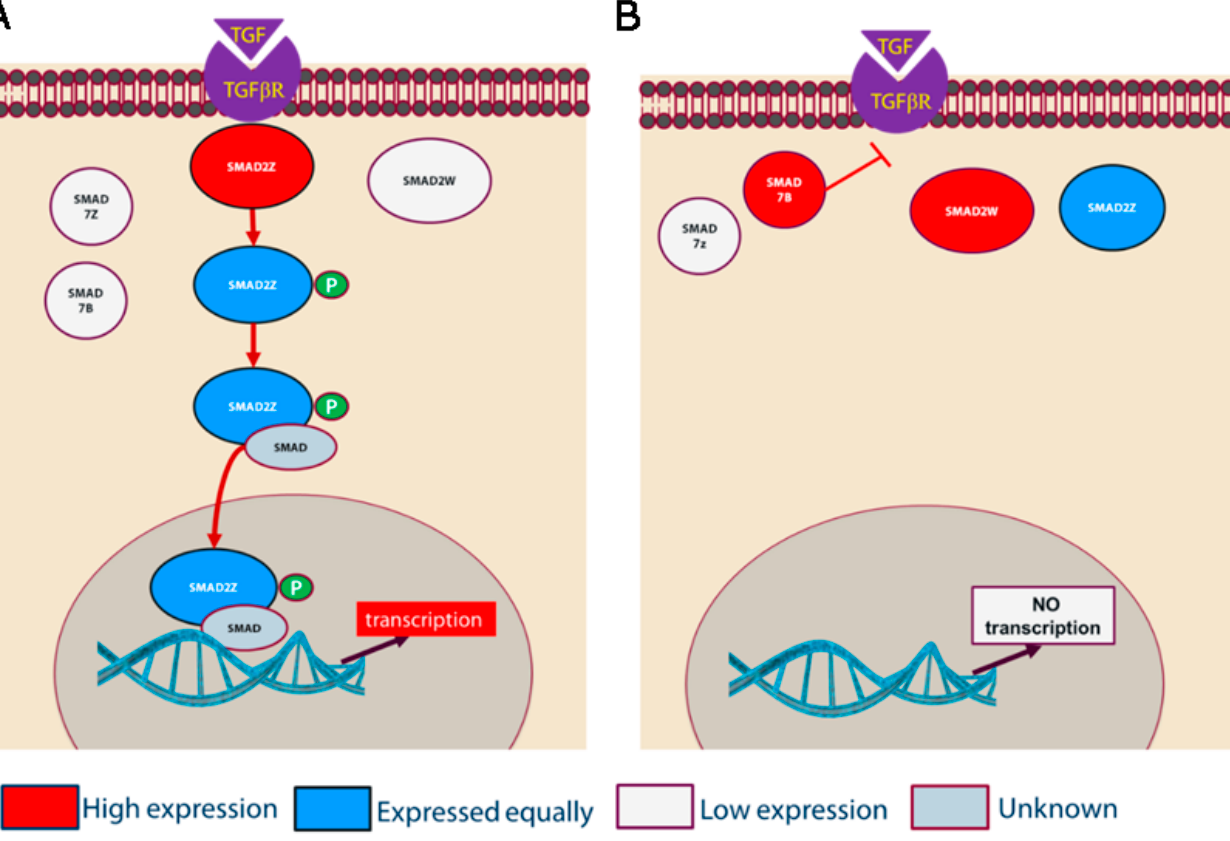
Figure 6. A model of the TGF β /Activin-signaling pathway in chicken male ( A ) and female ( B ) PGCs.